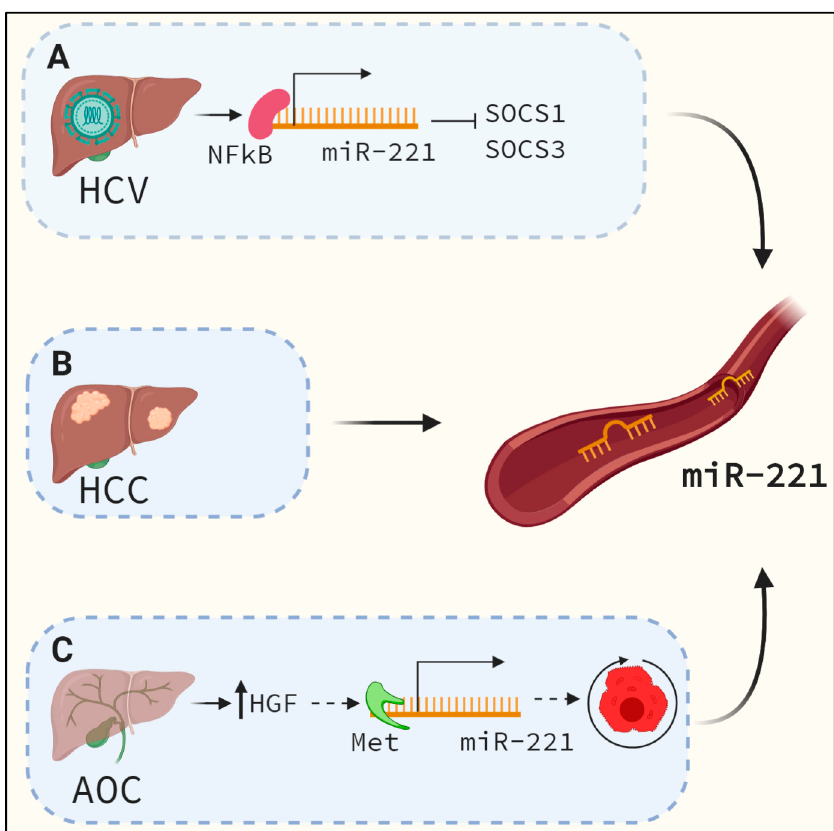
Figure 3. The main etiologies of liver fibrosis are chronic viral hepatitis infection, NASH and cholestatic diseases. If left untreated, extensive liver fibrosis often leads to the development of HCC. At present, the most commonly used method to diagnose liver disease is biopsy, which is invasive and often time-consuming. More importantly, the biopsy is often performed at later stages, by which time the only effective treatment option is transplantation. MiR-221 has been shown as a miRNA that can serve as a serum biomarker for diagnosis, to distinguish different diseases and as a marker of recovery. ( A ) HCV is one of the most prevalent causes of liver fibrosis. Multiple studies have shown miR-221 upregulation in the sera of patients with HCV. Furthermore, in HCV, miR-221 expression is under the control of NF-Kb, and it targets SOCS1 and SOCS3 . ( B ) HCC is the fourth leading cause of cancer-related deaths worldwide. High levels of miR-221 have been detected in HCC tissues and in the sera of patients with HCC. Based on the serum levels, miR-221 can be used together with AFP as a biomarker of HCC development, severity and outcome. Patients with high miR-221 had more advanced HCC and lower survival rates than those with low miR-221 serum levels. ( C ) In contrast, in AOC, the upregulation of miR-221 in patient’s sera is considered a sign of recovery. In AOC, hepatocyte proliferation and liver regeneration occur due to high HGF signaling. HGF is the key ligand for the receptor tyrosine kinase, c-Met, which, in turn, enhances miR-221 transcription. High levels of miR-221 in the liver repress SOCS1 levels. Since SOCS1 is an inhibitor of HGF signaling, its repression by miR-221 leads to enhanced HGF signaling and active liver regeneration and recovery.